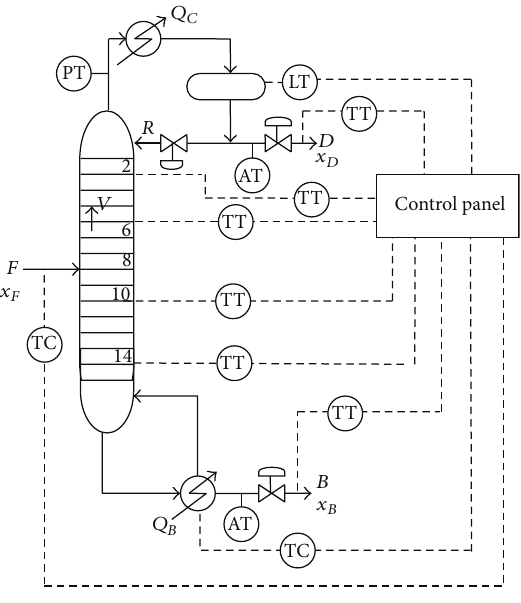
Figure 2: Pilot plant distillation